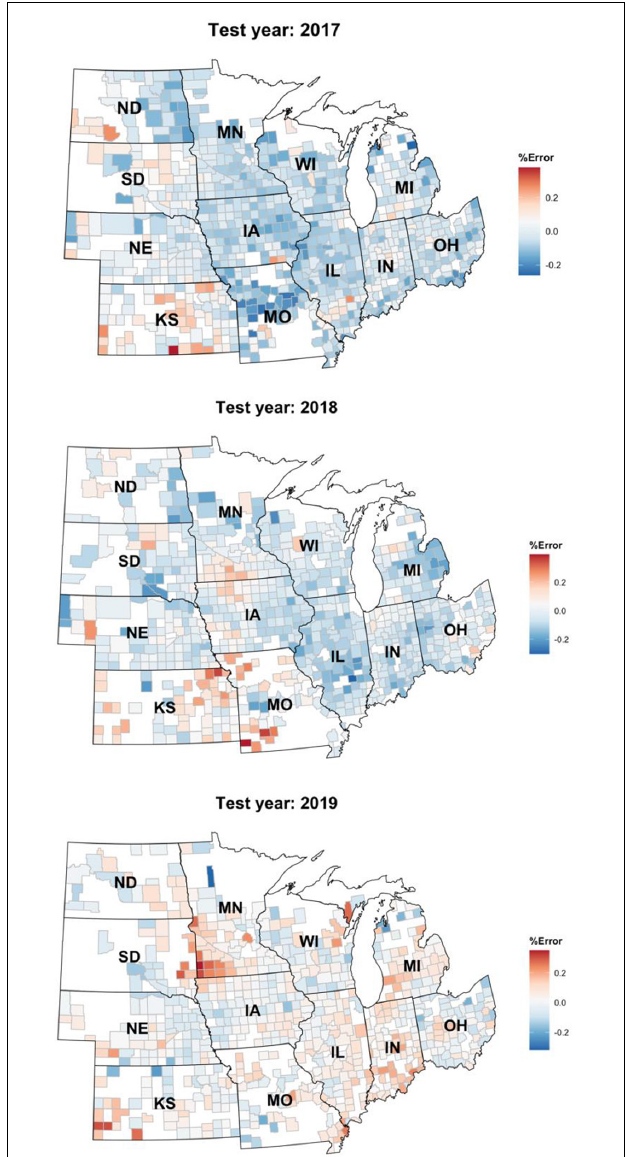
FIGURE 7 | Relative percentage error of the Homogenous GEM predictions shown on a choropleth map of the US Corn Belt.